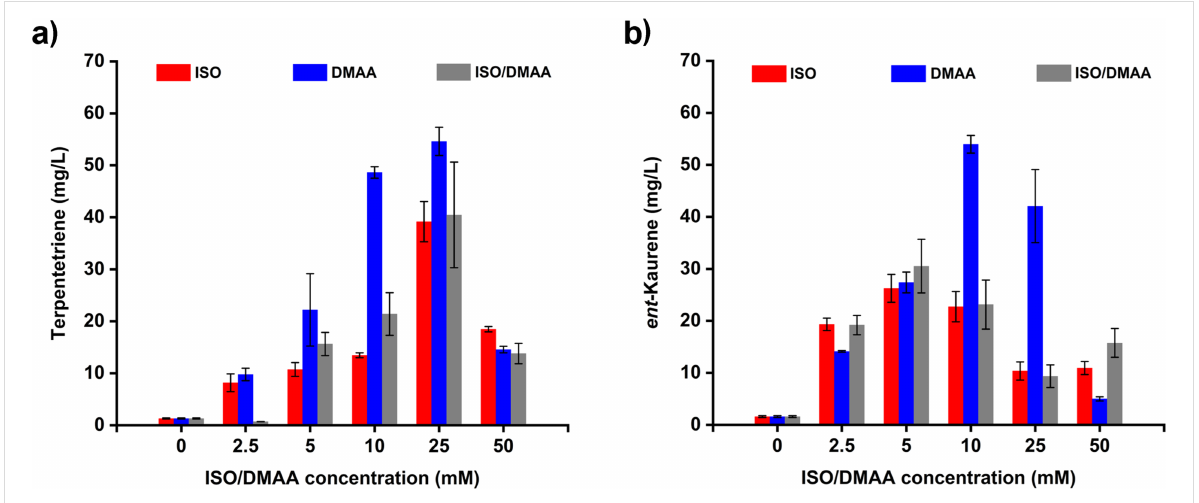
Figure 4: Optimizing the ratios of ISO/DMAA for overproducing terpentetriene (a) and ent -kaurene (b). Red: ISO; blue: DMAA; gray: ISO/DMAA 3:1 mixture. All product yields are reported as means ± SD of three replicates.